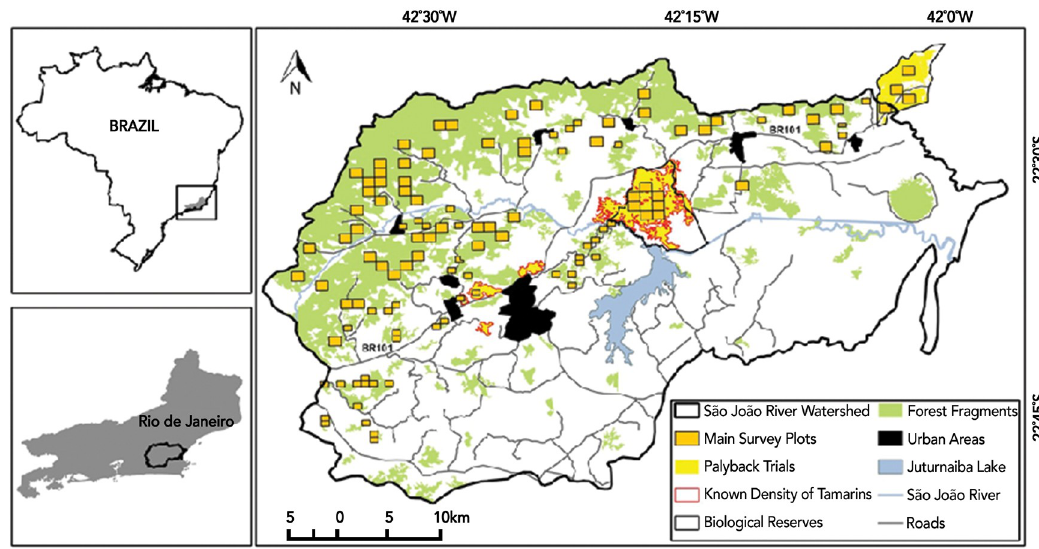
Fig 2. Locations of experimental and survey playbacks in the S ã o Jo ã o river basin. S ã o Jo ã o river basin, geographic range of most golden lion tamarins. Forest fragments (green) were identified using Landsat satellite images. Orange squares indicate randomly selected, 48 ha or 120 ha quadrats sampled in the playback survey. Observers played recorded GLT vocalizations at points 200 m apart along transects in each quadrat, noting responses by GLTs. Yellow polygons are locations of experimental playback trials to estimate the detection function. Density of tamarins in fragments bordered by red were obtained from complete counts or home range